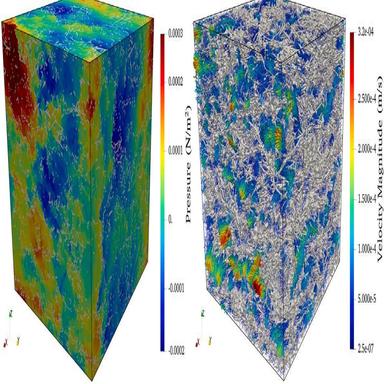
Pressure (left) and velocity (right) fields for FiberFormTM sample A for a permeability simulation in the direction.